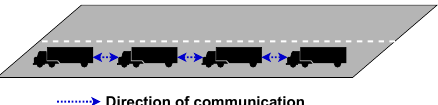
Figure 7. Predecessor-leader following topology of platooning communications.